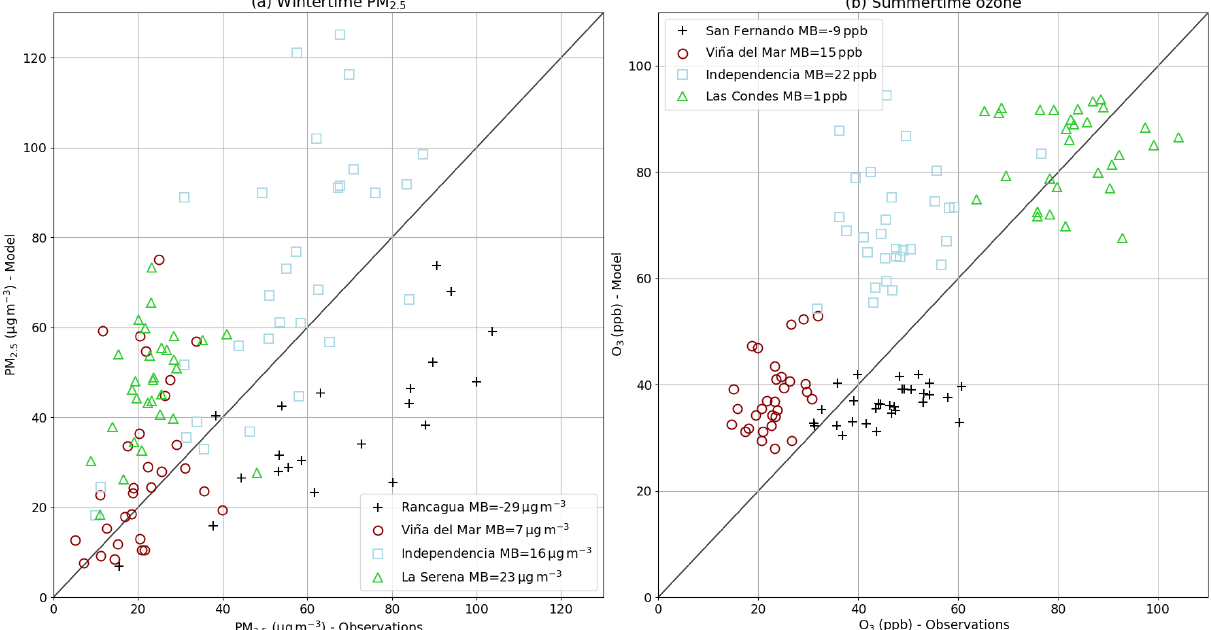
Figure 2. Comparison between observation and simulation for (a) wintertime daily average PM 2 . 5 concentrations and (b) summertime daily maximum O 3 mixing ratio. Wintertime and summertime correspond to the periods defined in Sect. 2.1, respectively. MB is the mean